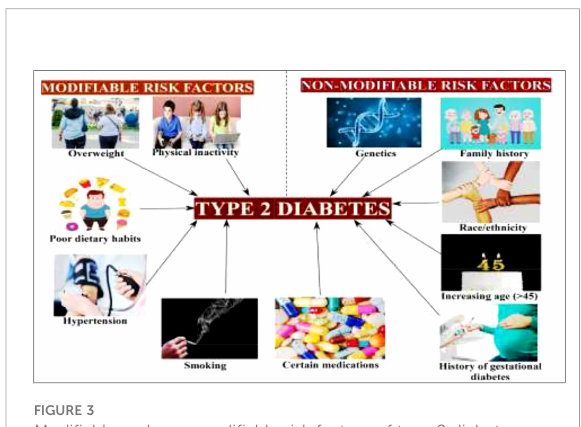
FIGURE 3 Modi fi able and non-modi fi able risk factors of type 2 diabetes mellitus